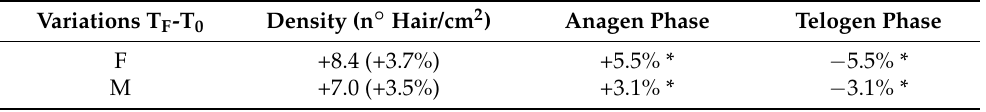
Table 2. Improvements (T F -T 0 ) in hair density and percentage of hair in anagen/telogen phase at the end of different anti-hair loss cosmetic treatments (lotions, shampoos or diet supplements) as a function of gender.